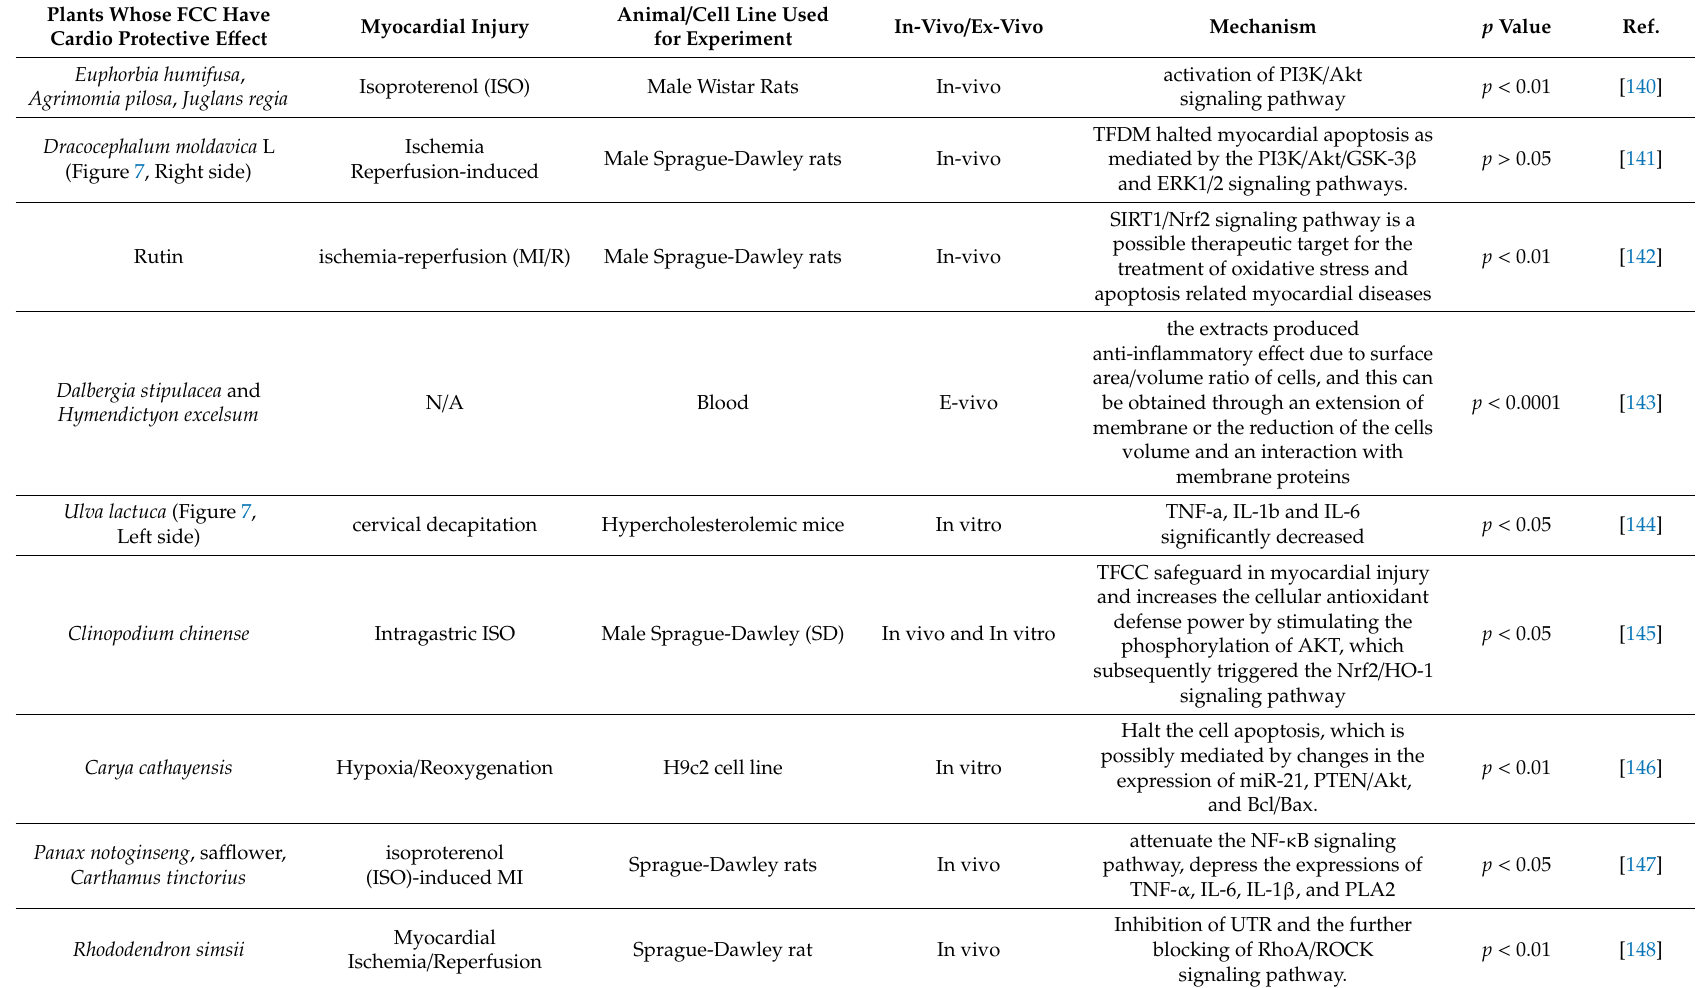
Table 3. Flavonoids having cardio protective e ff